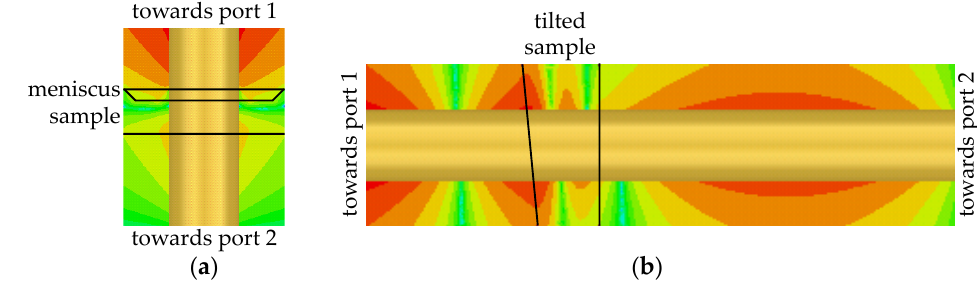
Figure 11. Fragment of the electric field distribution in the semi-open coaxial test fixture filled with a volume of distilled water simulated in HFSS. ( a ) The sample with the meniscus, ( b ) the sample tilted by 5° (rotated view). The dielectric plug is omitted for